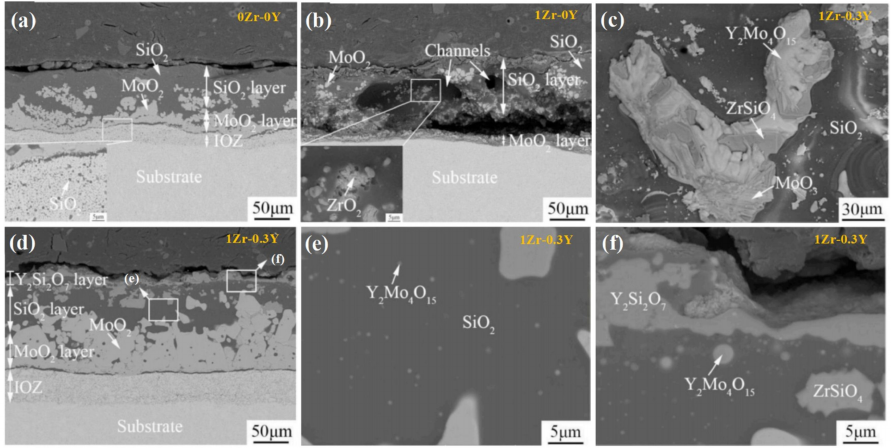
Figure 12. Cross-sectional and surface BSE images of three studied samples oxidized at 1250 ◦ C for different